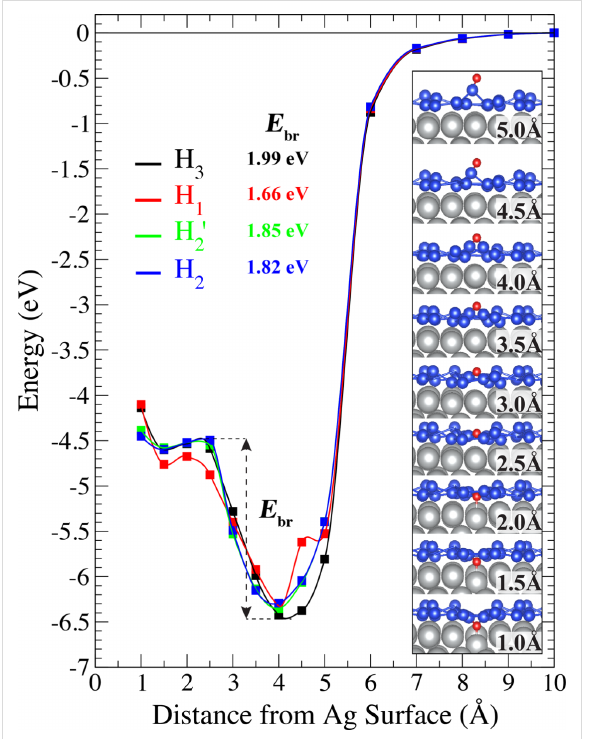
Figure 5: Indentation of an oxygen atom at different hollow sites. E br is the energy barrier the oxygen atom needs to pass inside the silicene environment. Inset graph shows the oxygen progression in H 1